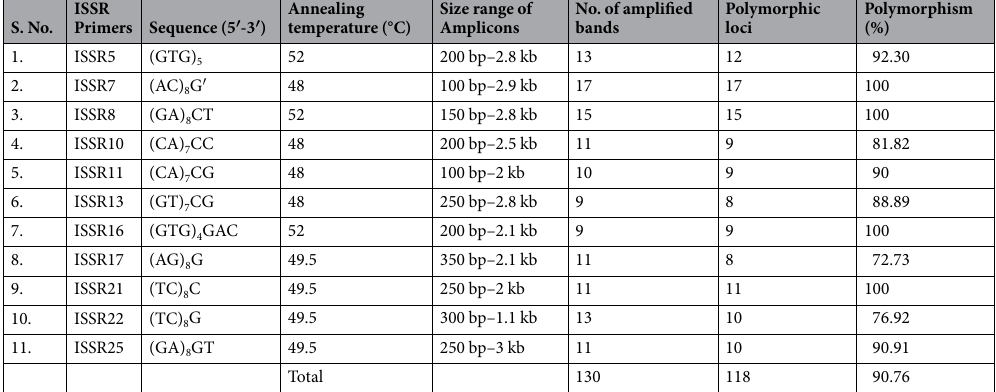
Table 1. Details of markers selected for the study and their amplified products.